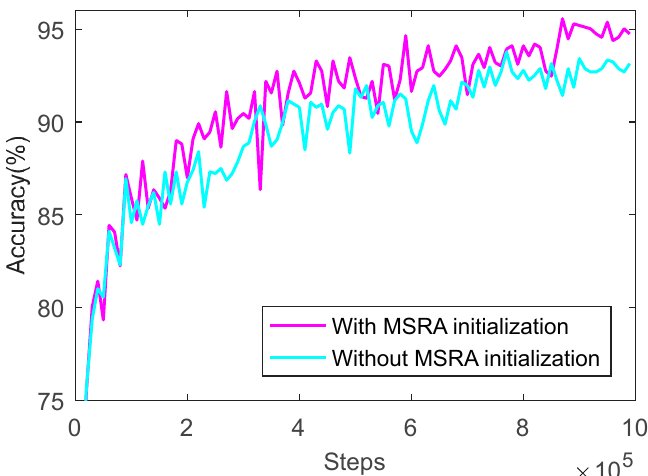
Figure 9. Prediction accuracy of CNN with MSRA (Microsoft Research Asia) initialization for weights using the training set.